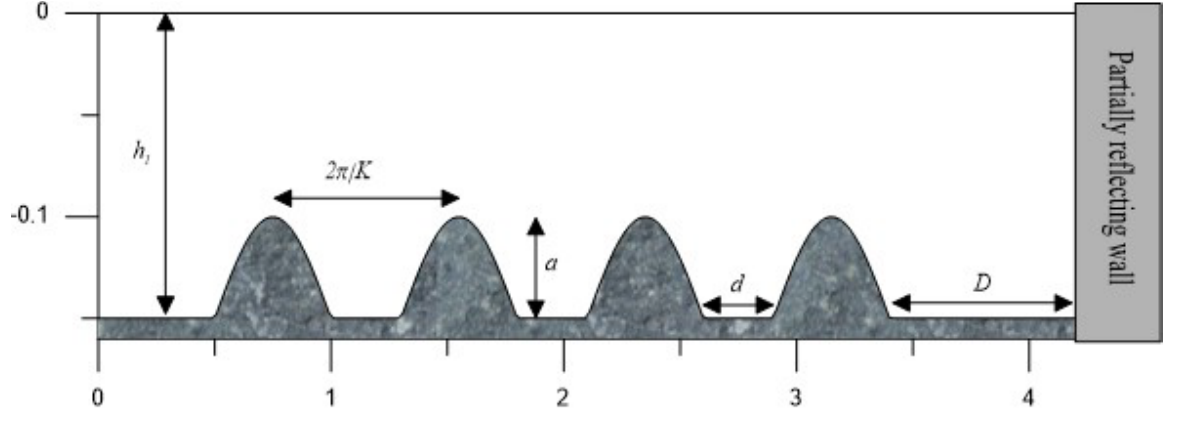
Figure 4. Problem definition of the oblique constructive and destructive Bragg scattering by four periodic half-cosine-shaped breakwaters placed near a partially reflecting wall.